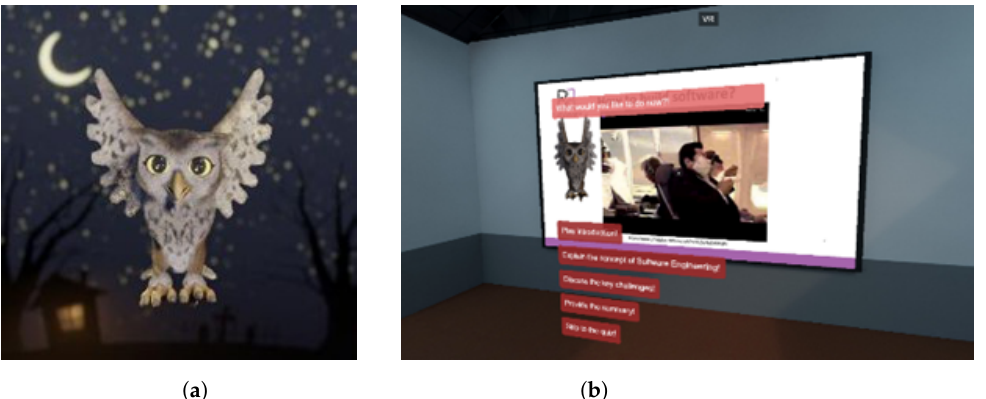
Figure 1. Example of a virtual classroom assistant: ( a ) an image of the virtual assistant, ( b ) the use of the virtual assistant for conversation in VR